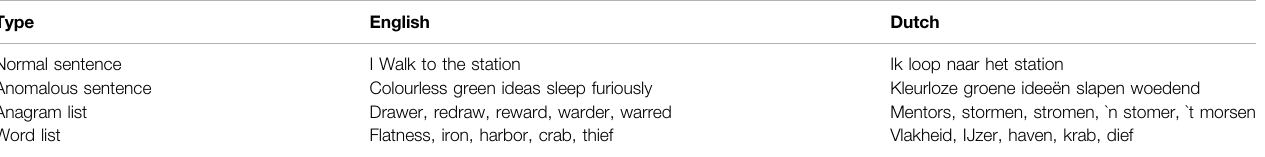
TABLE 1 | Examples of the four types of English and Dutch fi ve-word sentences/lists used in the rote-learning task.